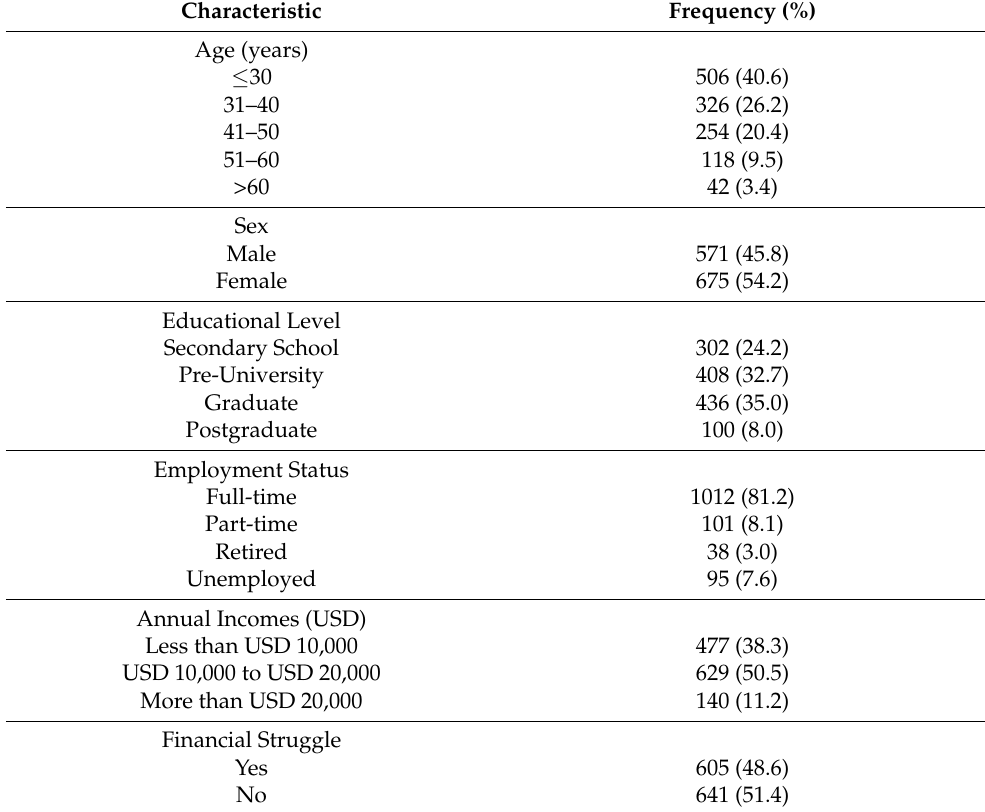
Table 1. Characteristics of